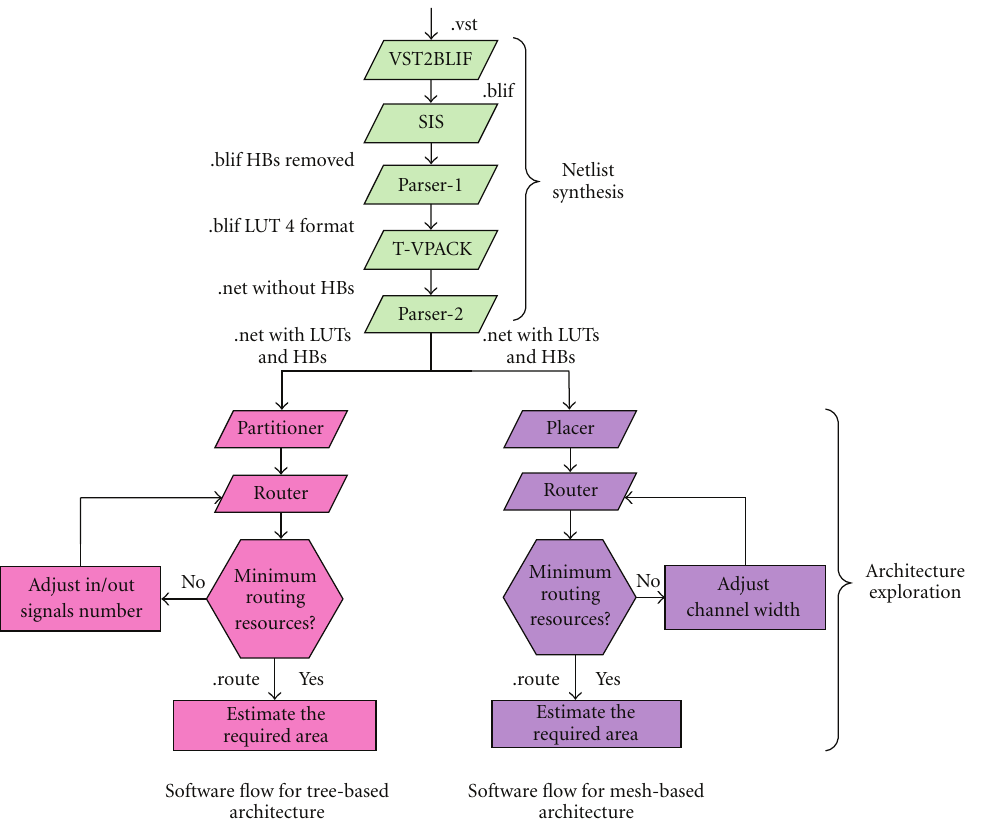
Figure 9: Software